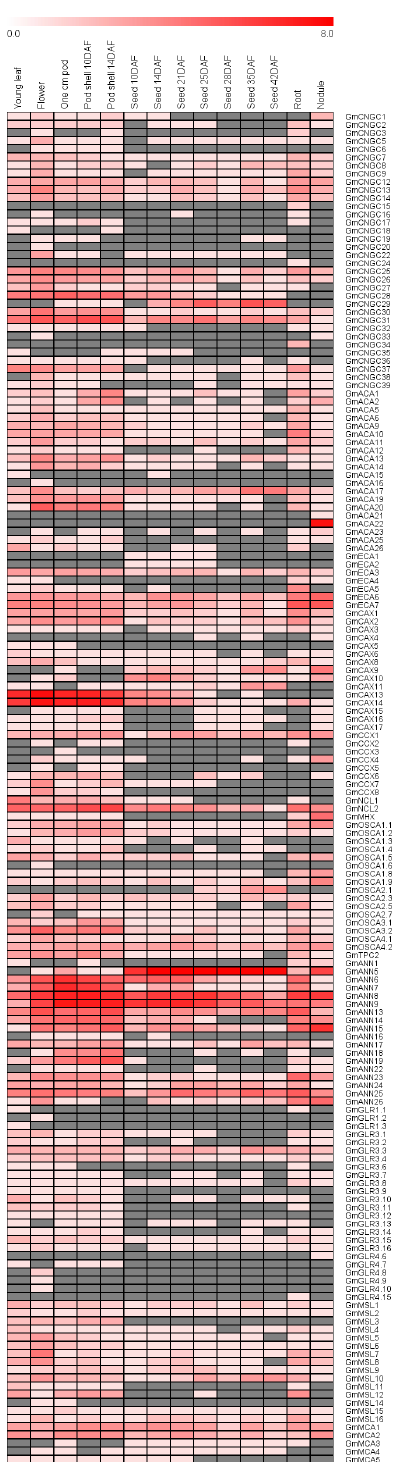
Figure 12. Heat map representation for tissue-specific expression patterns of the predicted calcium transporter genes according to Illumina RNA sequencing data (https://www.soybase.org/soyseq/). The Reads / Kb / Million (RPKM) normalized log2 transformed counts were visualized in the heat map. The red colors indicate expression intensity, and the gray color indicates no expression. DAF, days after